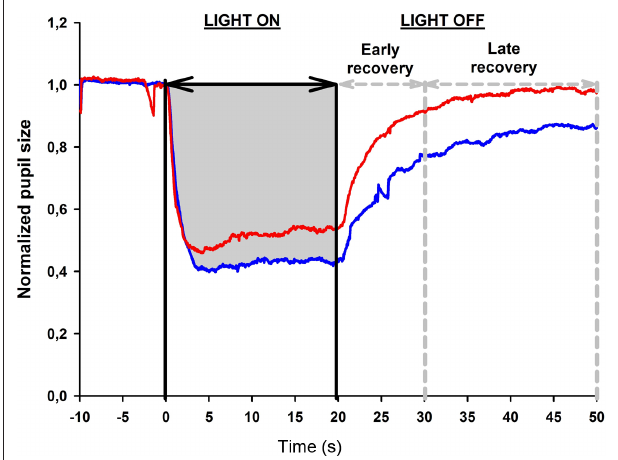
Figure 2 | Pupil response curve to selected wavelength light stimulation for one healthy subject. The stimulus is a 470 or 660 nm light at 300 cd/m 2 presented continuously for 20 s. The broken line represents the reference line of baseline pupil size. The normalized pupil size is displayed as a function of time for the blue light stimulus (blue line) and red light stimulus (red line). The pupil contraction is rapid, lasts approximately 2 s for both blue and red light stimuli and reaches maximum contraction at approximately the fourth second. The pupil remains contracted to blue light until the light termination (20th second), whereas pupillary escape is observed during red light stimulation.